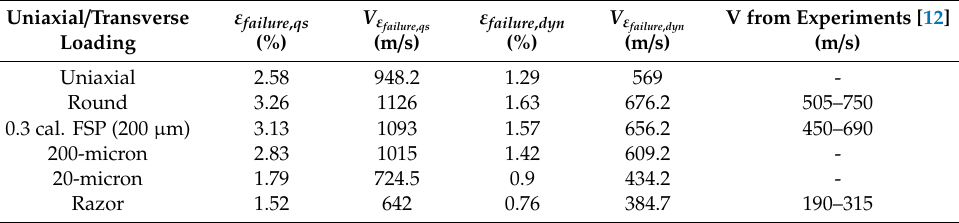
Table 2. Breaking speed predictions from axial failure